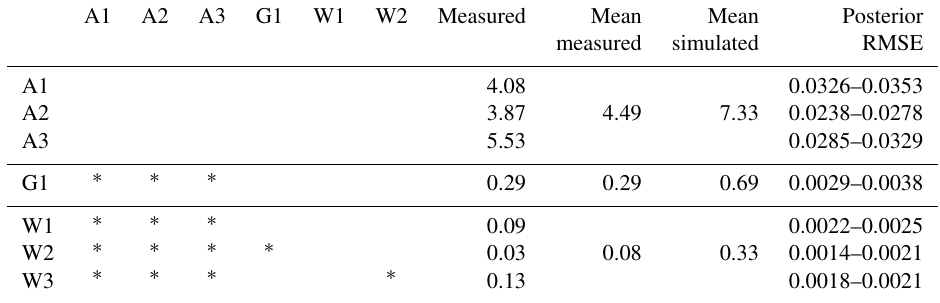
Table 2. Mean measured annual fluxes (November 2013–December 2015) on the different land use transects of the Vollnkirchener Bach study area. Differences between the investigated transects and land uses for measured and modelled N 2 O emissions inkg N–N 2 Oha − 1 a − 1 . A1 A2 A3 G1 W1 W2 Measured Mean Mean Posterior measured simulated